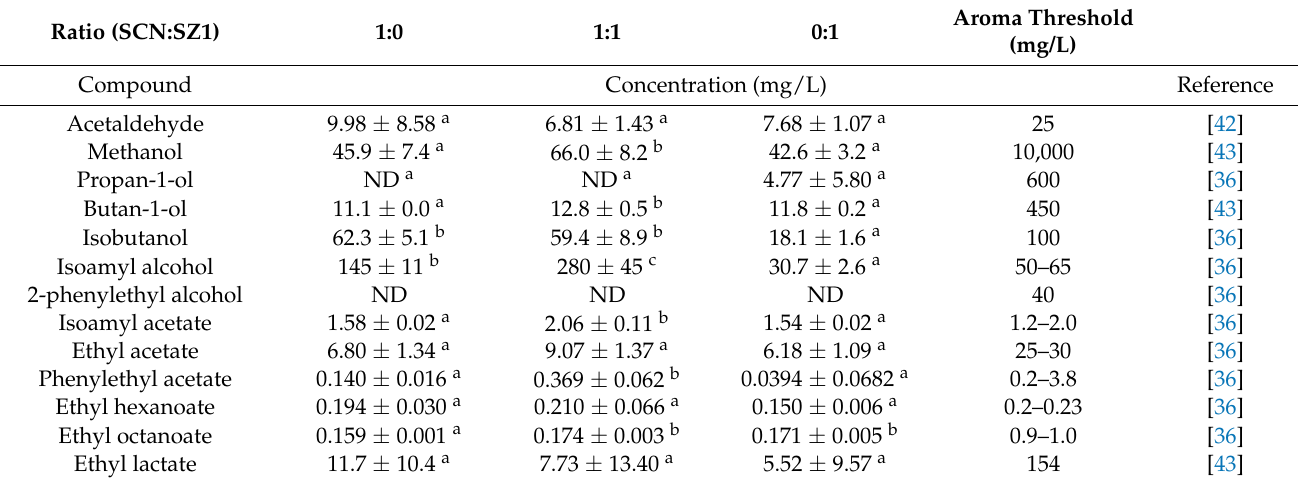
Table 6. Volatile organic compounds detected by GC-FID for SCN and SZ1 in monoculture and in mixed (1:1) culture high-gravity